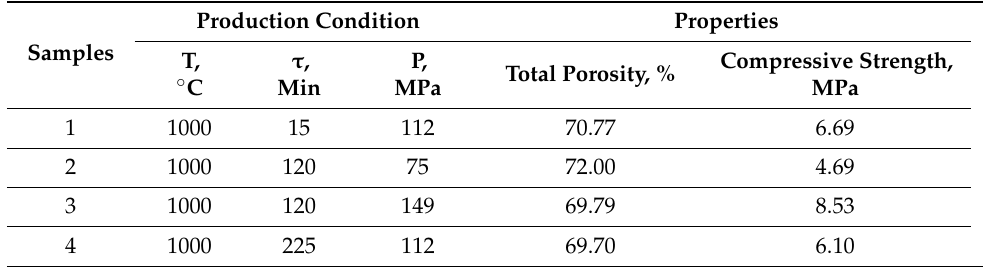
Table 9. Production condition and properties of rice husk ash silica compacts. Data from